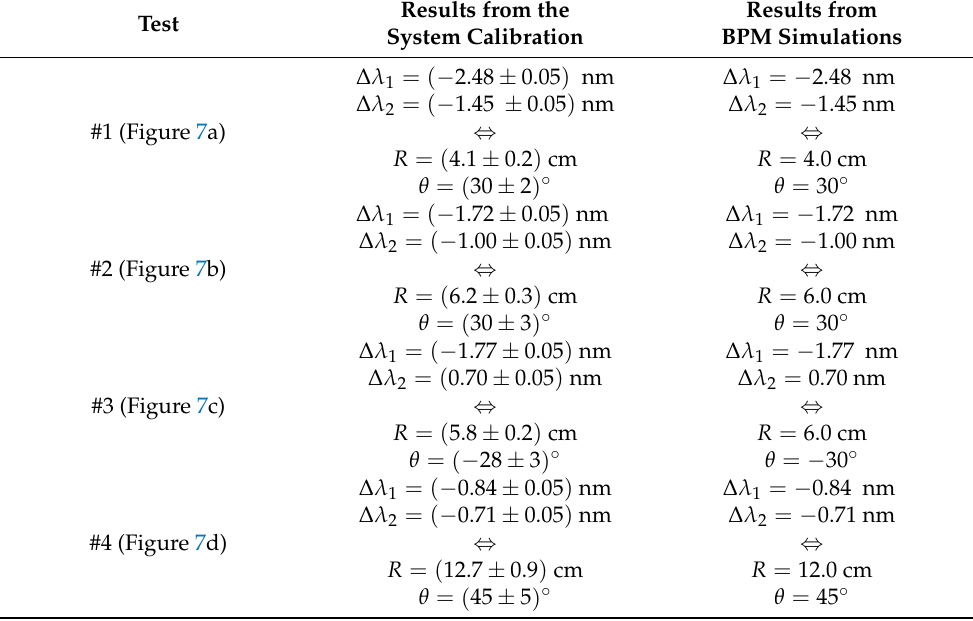
Table 2. Summary of the operation